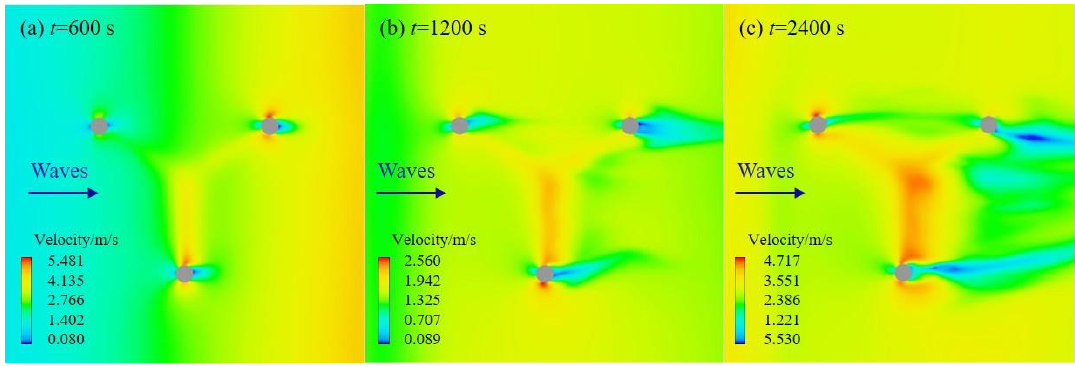
Figure 7. Flow velocity distribution around a tripod in the x - y section.